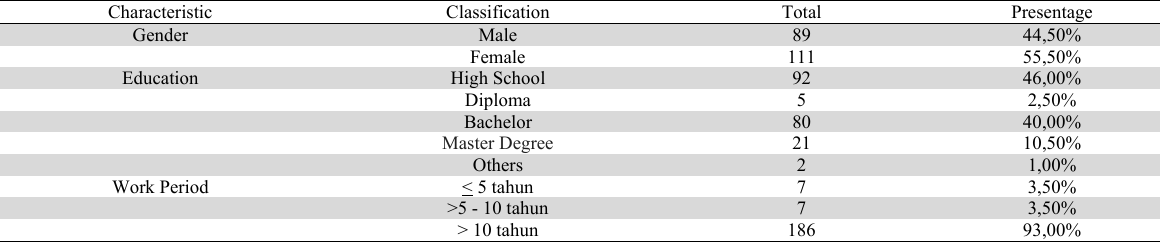
Characteristics of